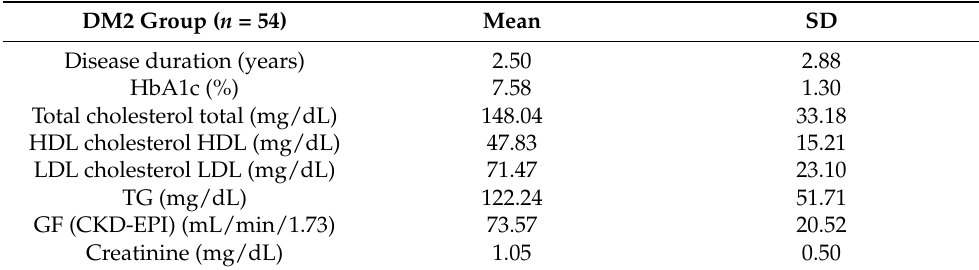
Table 1. Mean and standard deviation (SD) of the diabetic disease and systemic values (lipid levels and renal function) of the type 2 diabetic mellitus (DM2) patients. Abbreviations: DM2, diabetes mellitus type 2; HbA1c (%), glycosylated haemoglobin; HDL, high-density lipoprotein; LDL, low- density lipoprotein; TG, triglycerides; GF, glomerular filtration. DM2 Group ( n = 54) Mean SD Disease duration (years) 2.50 2.88 HbA1c (%) 7.58 1.30 Total cholesterol total (mg/dL) 148.04 33.18 HDL cholesterol HDL (mg/dL) 47.83 15.21 LDL cholesterol LDL (mg/dL) 71.47 23.10